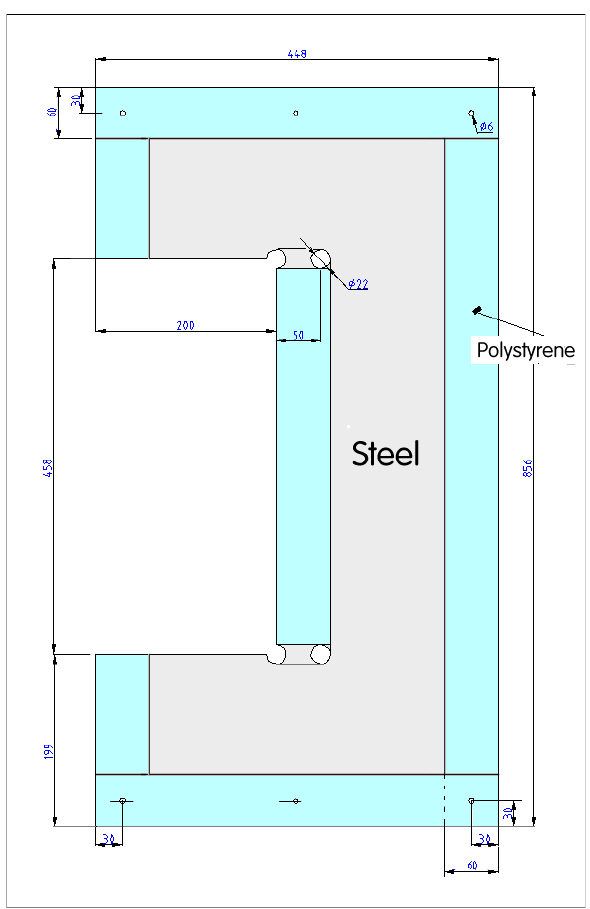
Fig. 27. Position of the 60 mm thick polystyrene block inside the sheet-metal walls. Available for the airflow is the grey colour